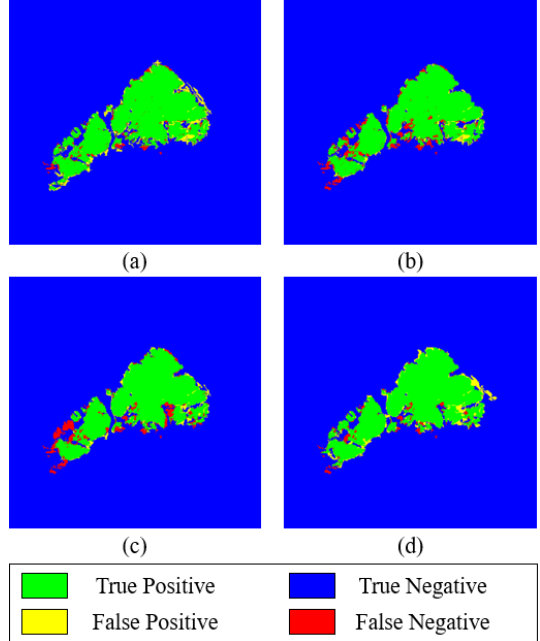
Figure 4. Burned area mapping results from OBIA with two pairs of images; (a) NDVI, (b) NBR; with one pair of images (c) NDVI, (d) NBR